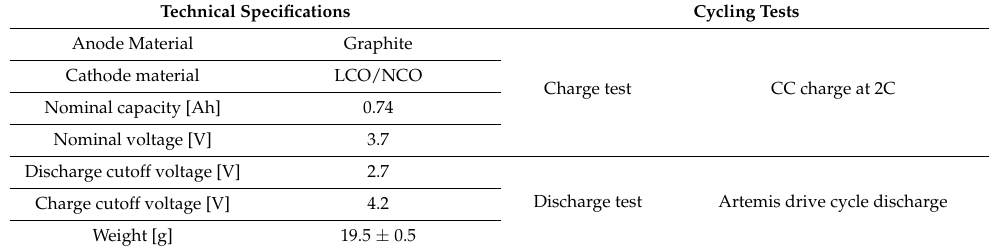
Table 1. Technical specifications and battery test procedures of the eight batteries.